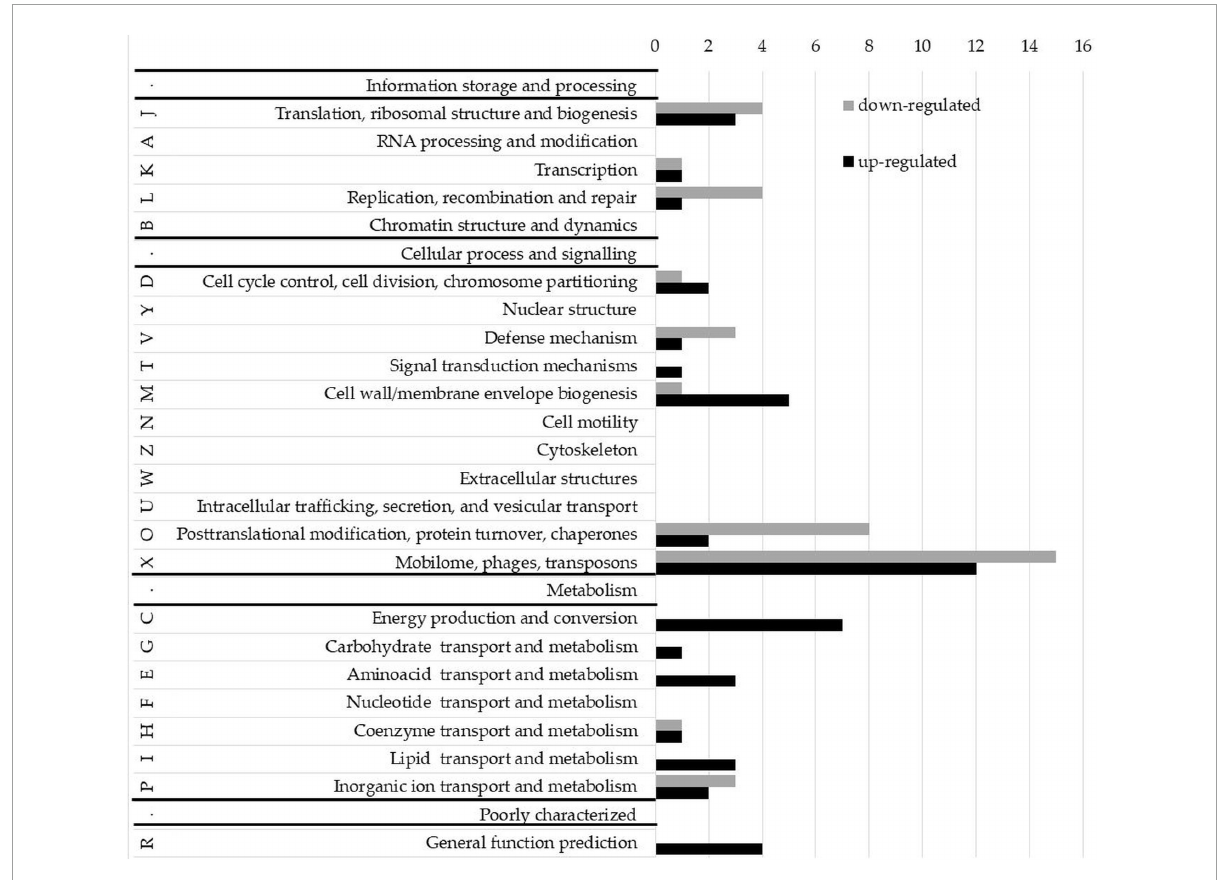
FIGURE7 Clusters of orthologous groups (COG) classification of proteins encoded by upregulated and downregulated genes in the NgoAV knock-out N. gonorrhoeae (Ngo (cid:49) AV) vs. the wt N. gonorrhoeae FA1090 strain. Letters represent COGs categories; numbers–the number of proteins in each category; black bars–number of proteins encoded by upregulated genes; gray bars–number of proteins encoded by downregulated genes. S category (function unknown) is not